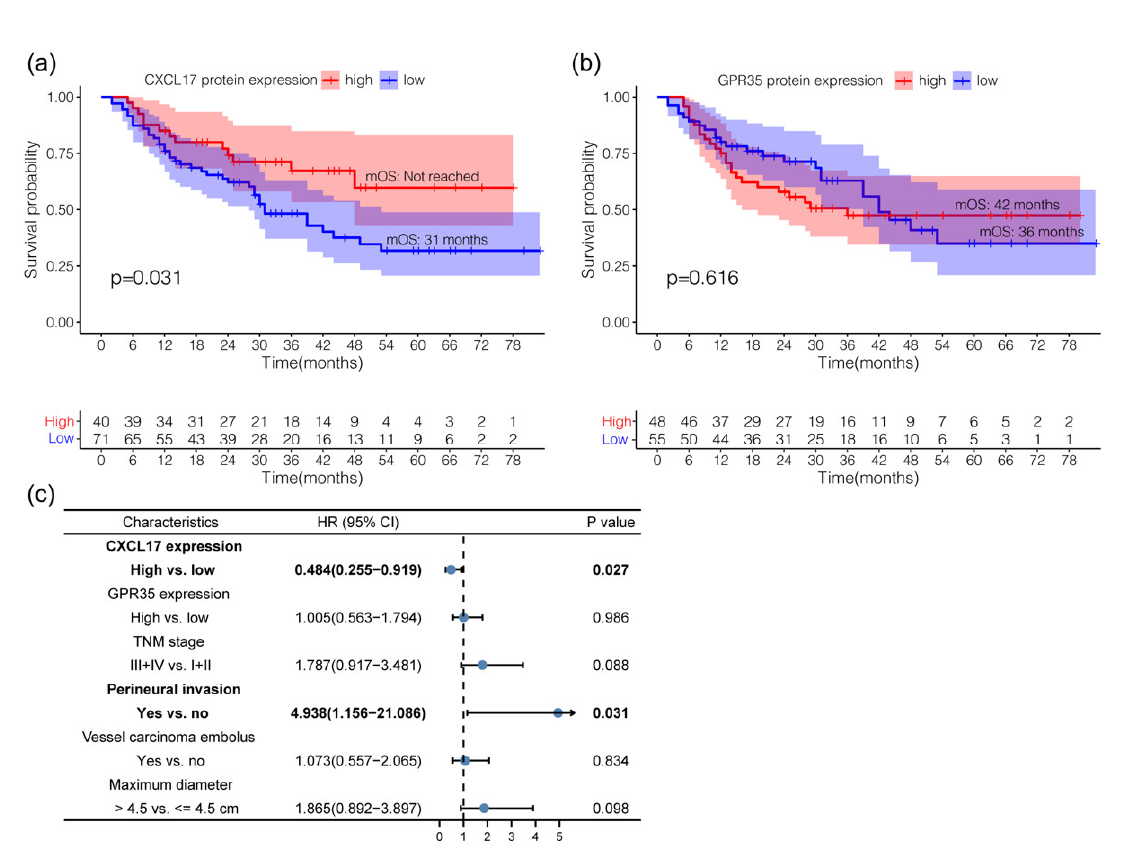
Figure 4. Survival analysis of CXCL17 ( a ) and GPR35 ( b ), respectively. Multivariate survival analy- sis ( c ).